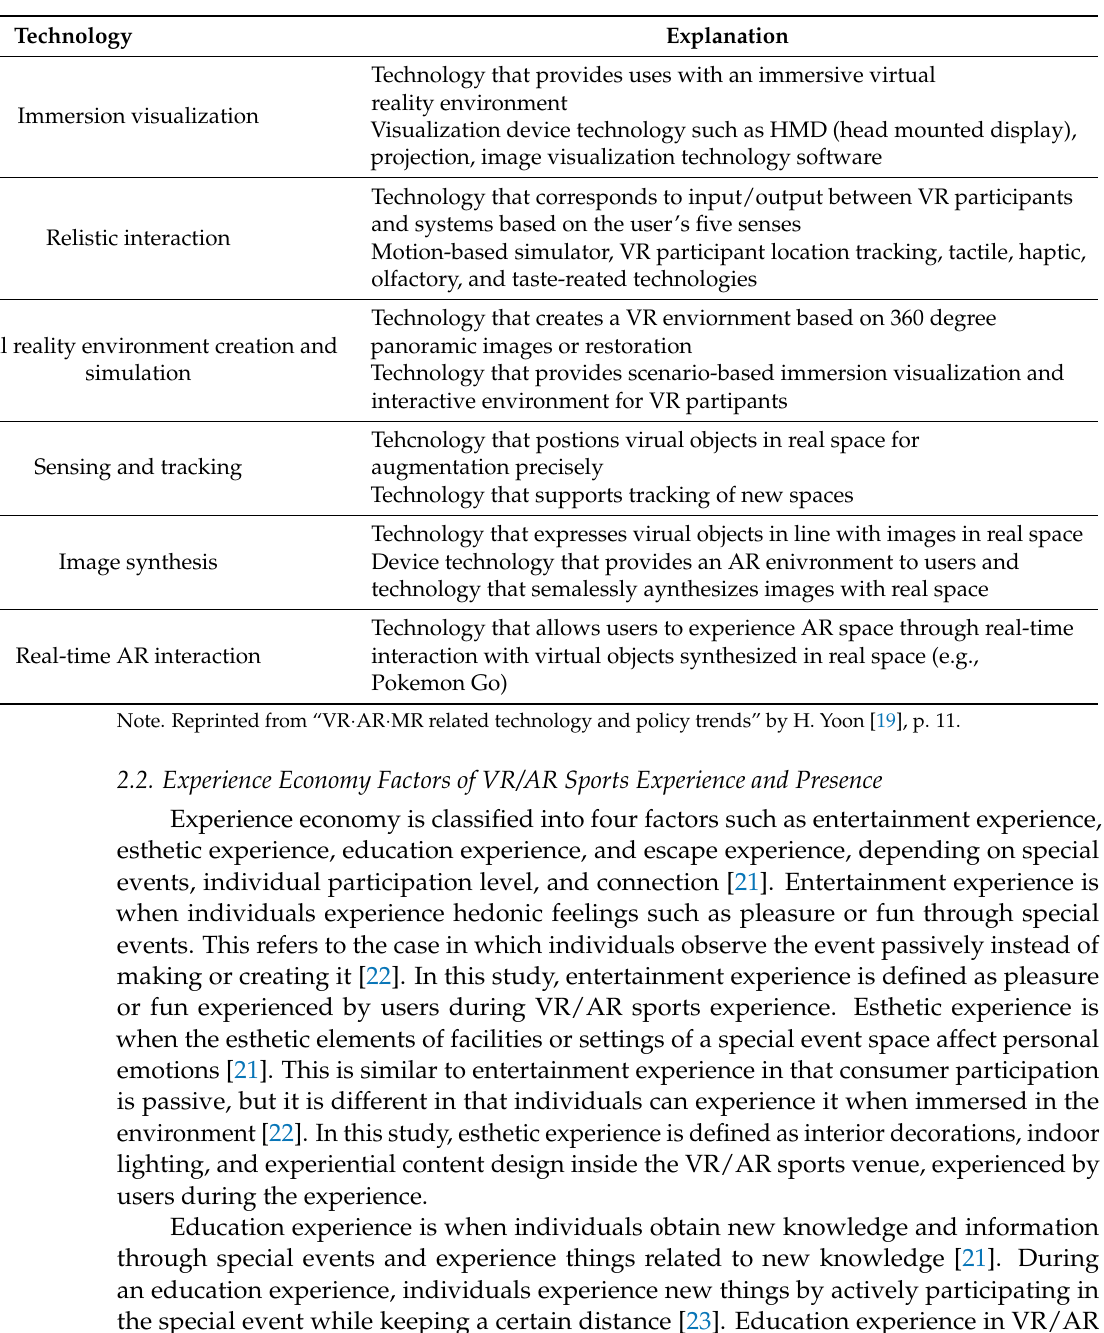
Table 1. VR/AR core